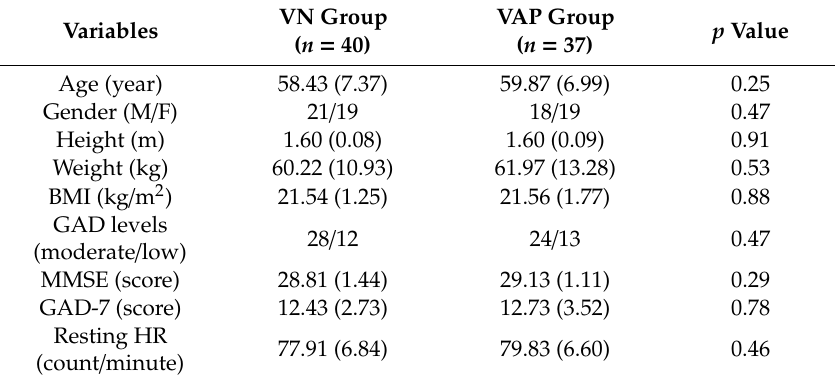
Table 1. Baseline demographic characteristics of the participants (mean (SD)).